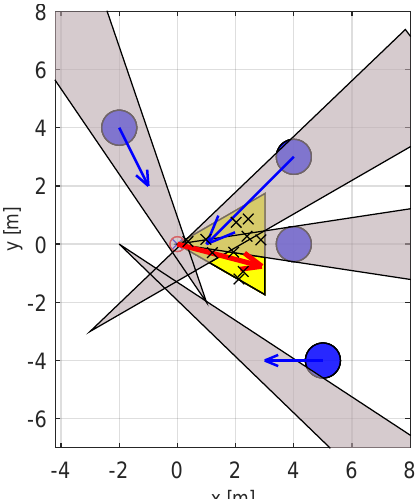
Figure 10. VO − type diagram of the crowded scenario. The robot is positioned in the origin and is denoted by a red circle, the goal position is at [8,0]. The yellow area represents the reachable available velocities, with the red arrow being the optimal velocity corresponding to the fastest solution. The blue disks represent the obstacles with their velocities, while the gray triangles are the corresponding VOs. The x-marks distributed within the area of reachable velocities are the initial population of the GAVO variants. The fact the majority of the yellow area is covered by the VOs shows that this is a “difficult” scenario. Table 1. Results of experiments on the crowded scenario using different GAVO variants, population sizes N and GAP parameters.